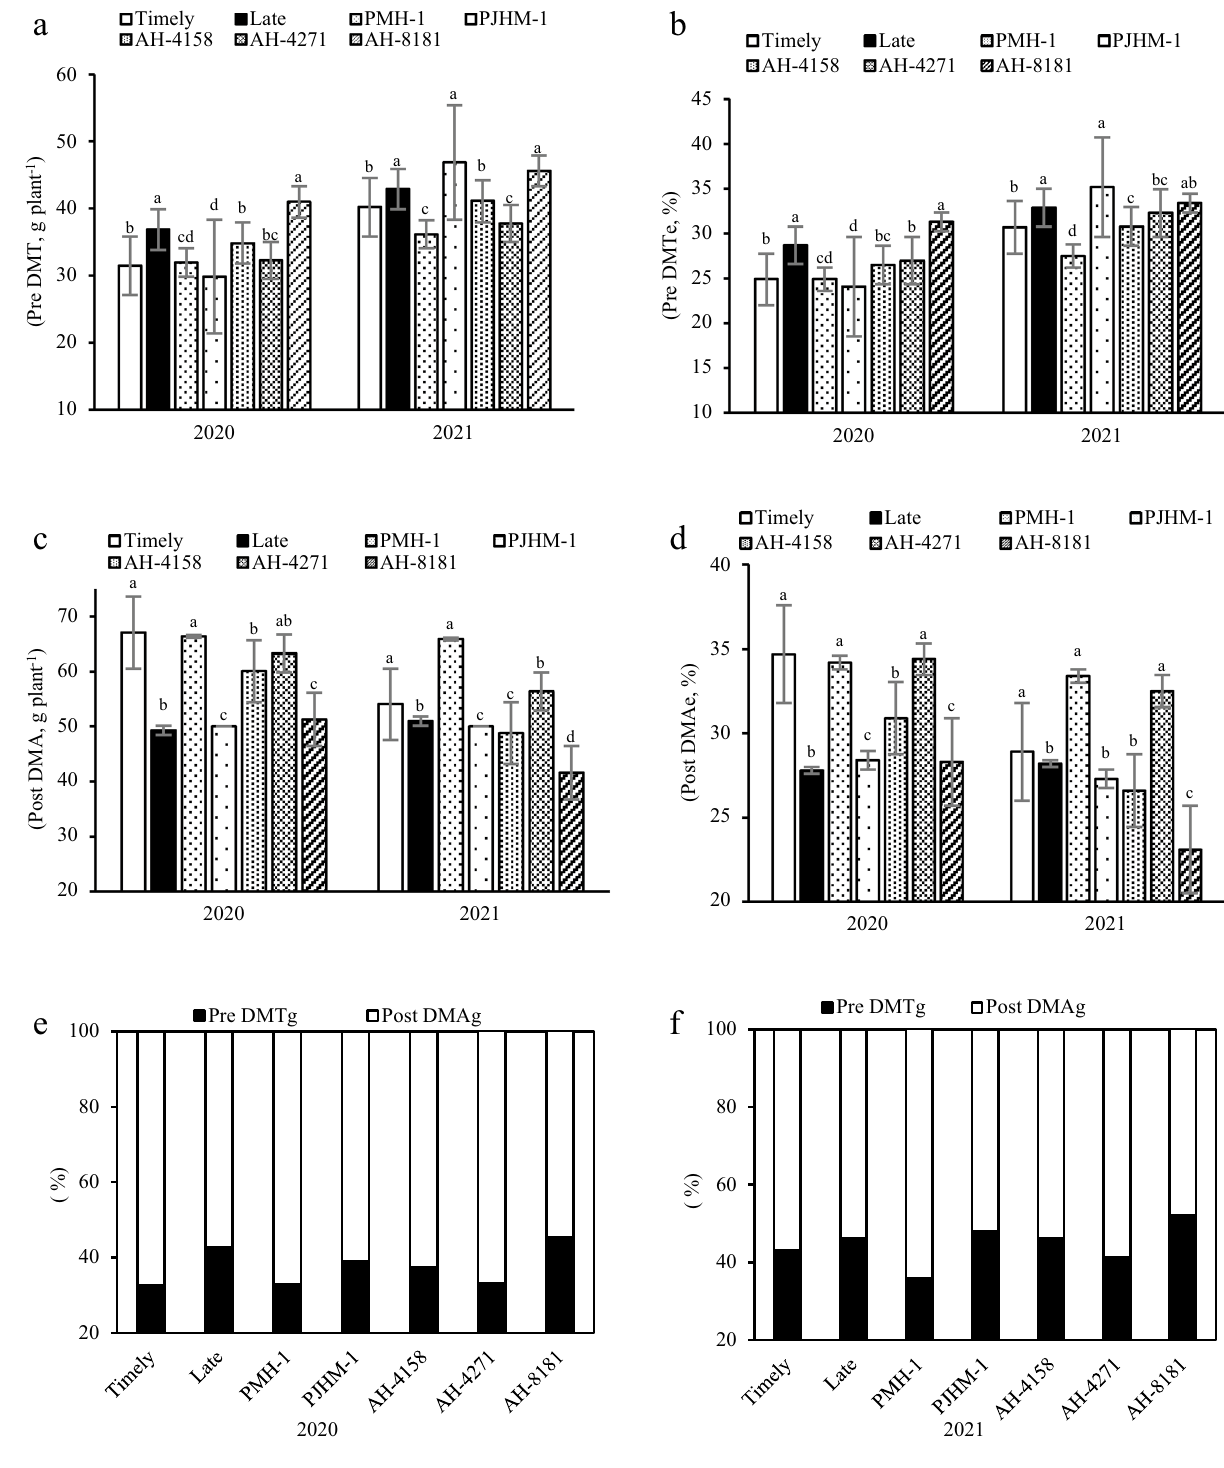
Figure 1. Pre DMT- pre-anthesis dry matter translocation ( a ), Pre DMTe- pre-anthesis dry matter translocation efficiency ( b ); Post DMA- post-anthesis dry matter accumulation ( c ), Post DMAe- post-anthesis dry matter accumulated efficiency ( d ); Pre DMTg- pre-anthesis dry matter translocation and Post DMAg- post- anthesis dry matter accumulation contribution to grain yield ( e , f ). Within years, sowing time, and genotypes, different letters on the individual bars of a figure indicate significant difference ( p ≤